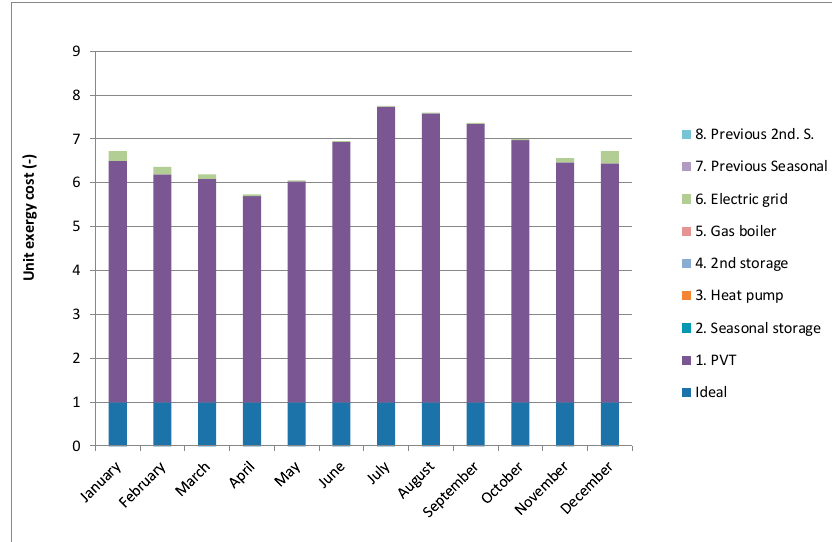
Figure 17. PVT: Cost formation by irreversibility.